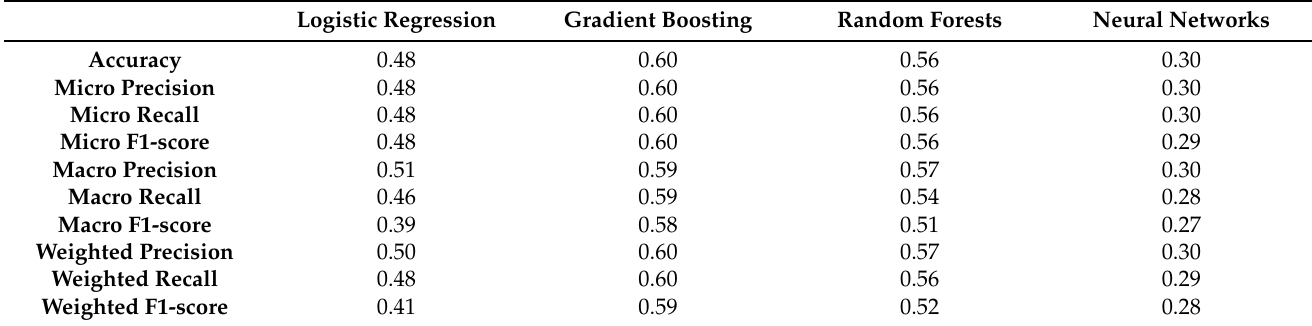
Table 4. Lane detection—results comparison.